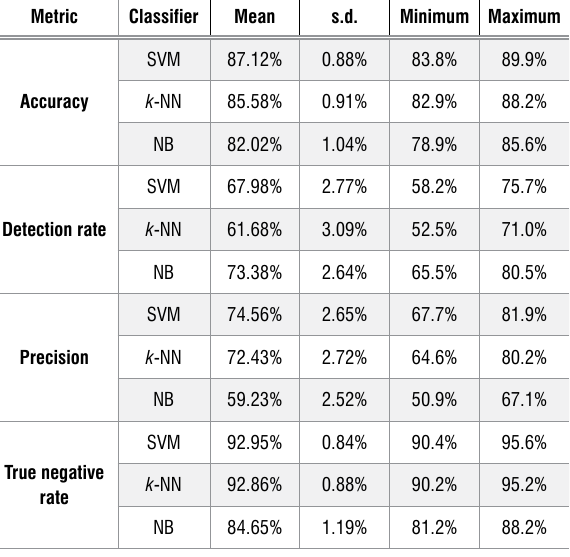
Performance measures for the three